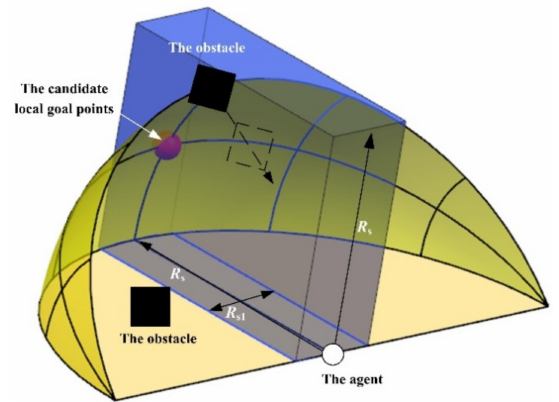
Figure 5. The selection of the candidate local